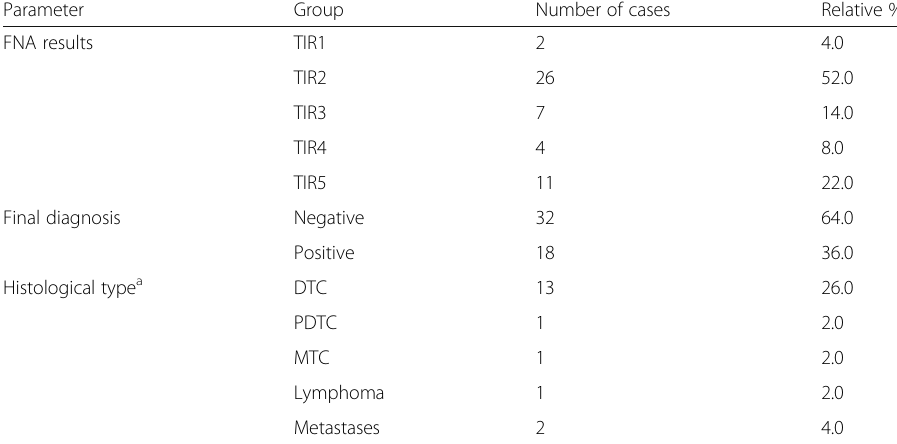
Table 2 Descriptive statistics of the cohort of patients in the study Parameter Group Number of